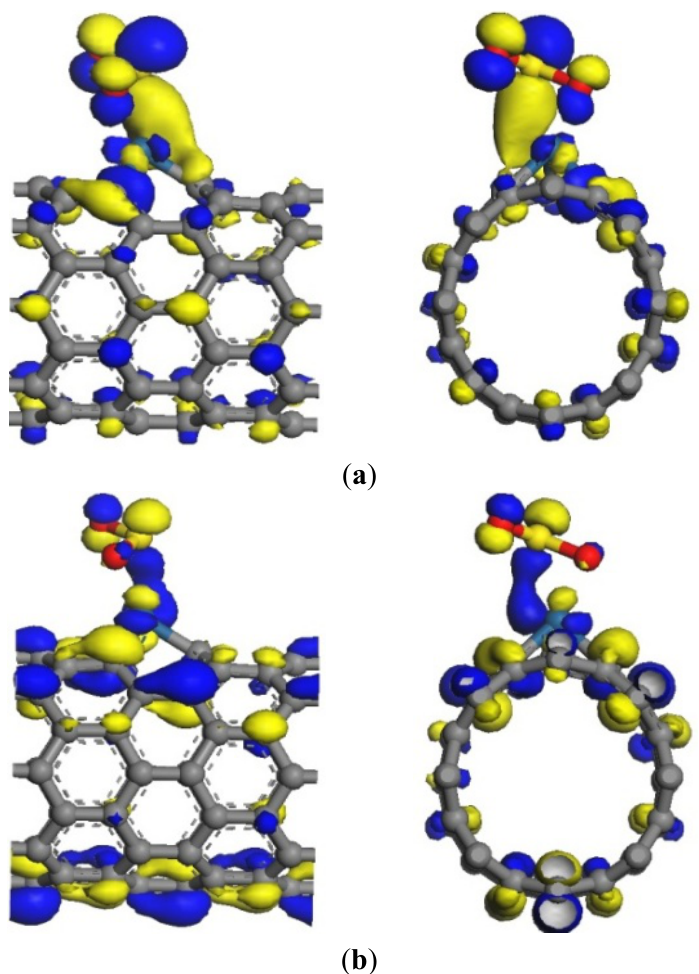
Figure 4. Frontier orbital energy level of SO ( b ) LUMO (–4.923